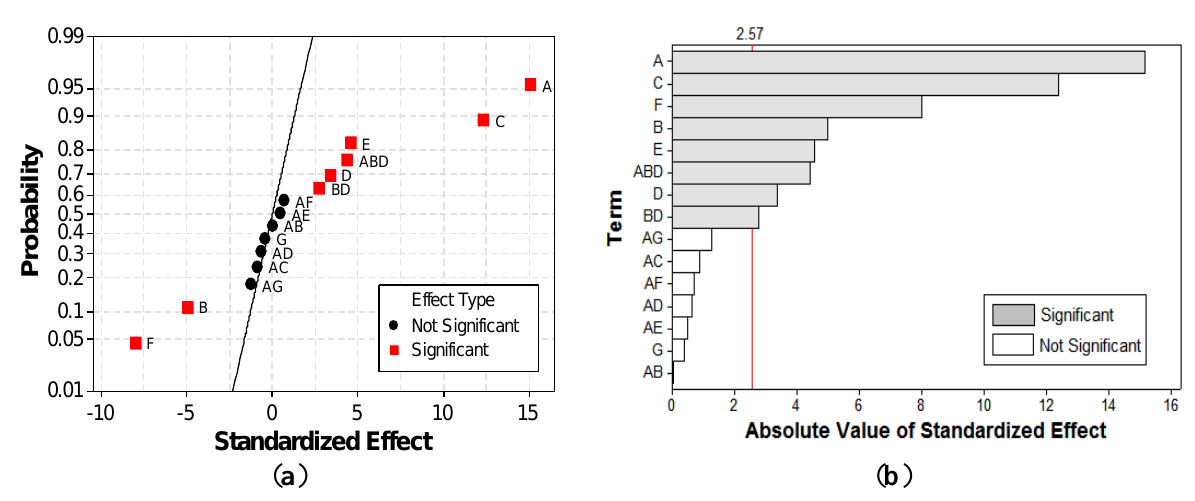
Figure 7. Normal plot of the ( a ) standardized effects; and ( b ) standardized Pareto chart for Y response.